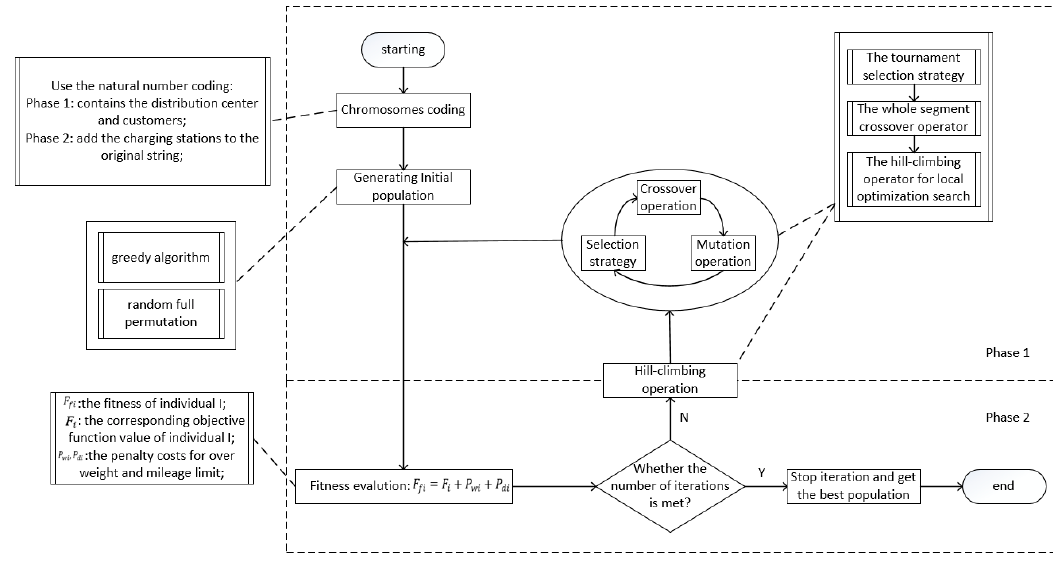
Figure 2. Basic process of hybrid genetic algorithm (HGA).